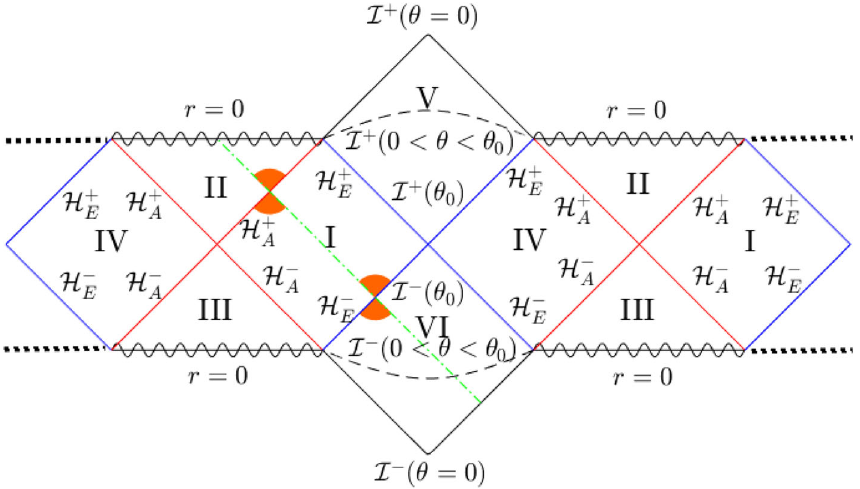
θ = θ θ = 0. Since 0 , and closes the diagram with a diamond shape for the metric is singular for θ = 0 ,θ 0 , the diagrams for those values do not represent the spacetime, so the conformal infinity in those cases has to be understood as a limit when θ → 0 ,θ 0 . The diagram is invariant under ϕ